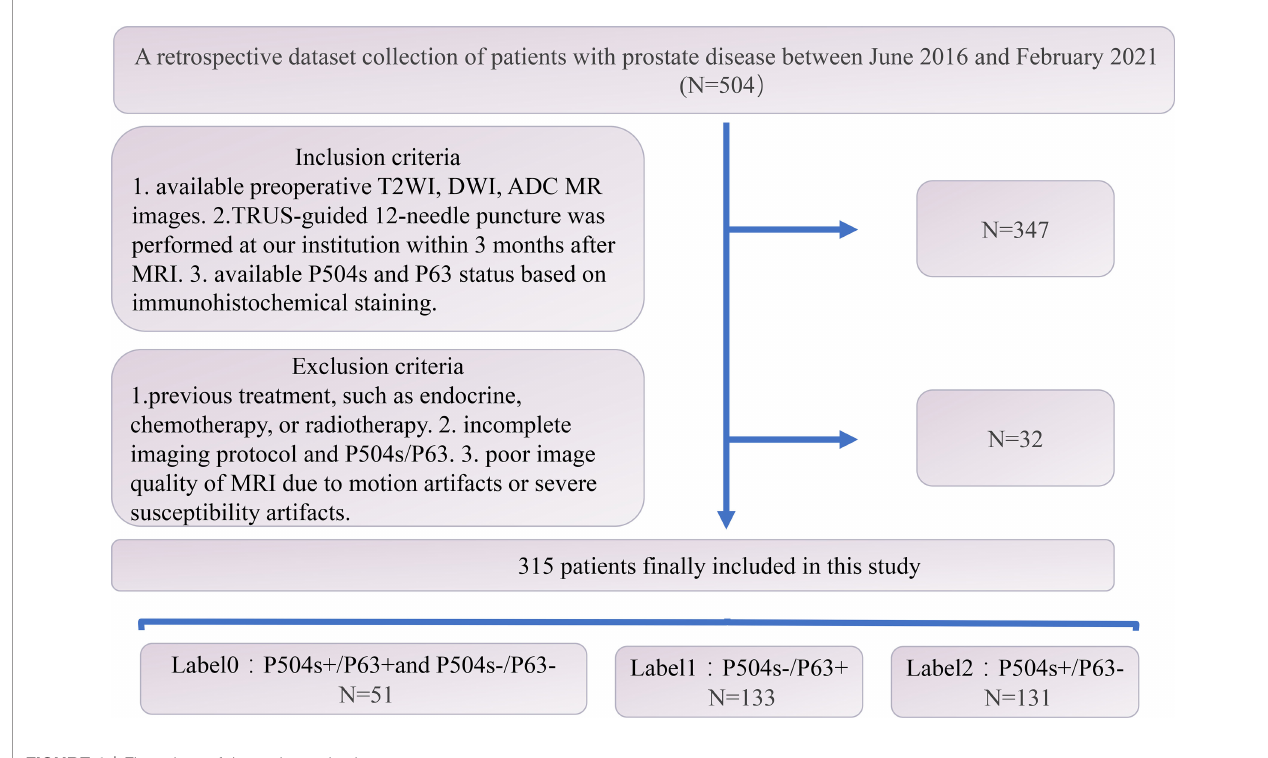
FIGURE 1 | Flow chart of the patient selection